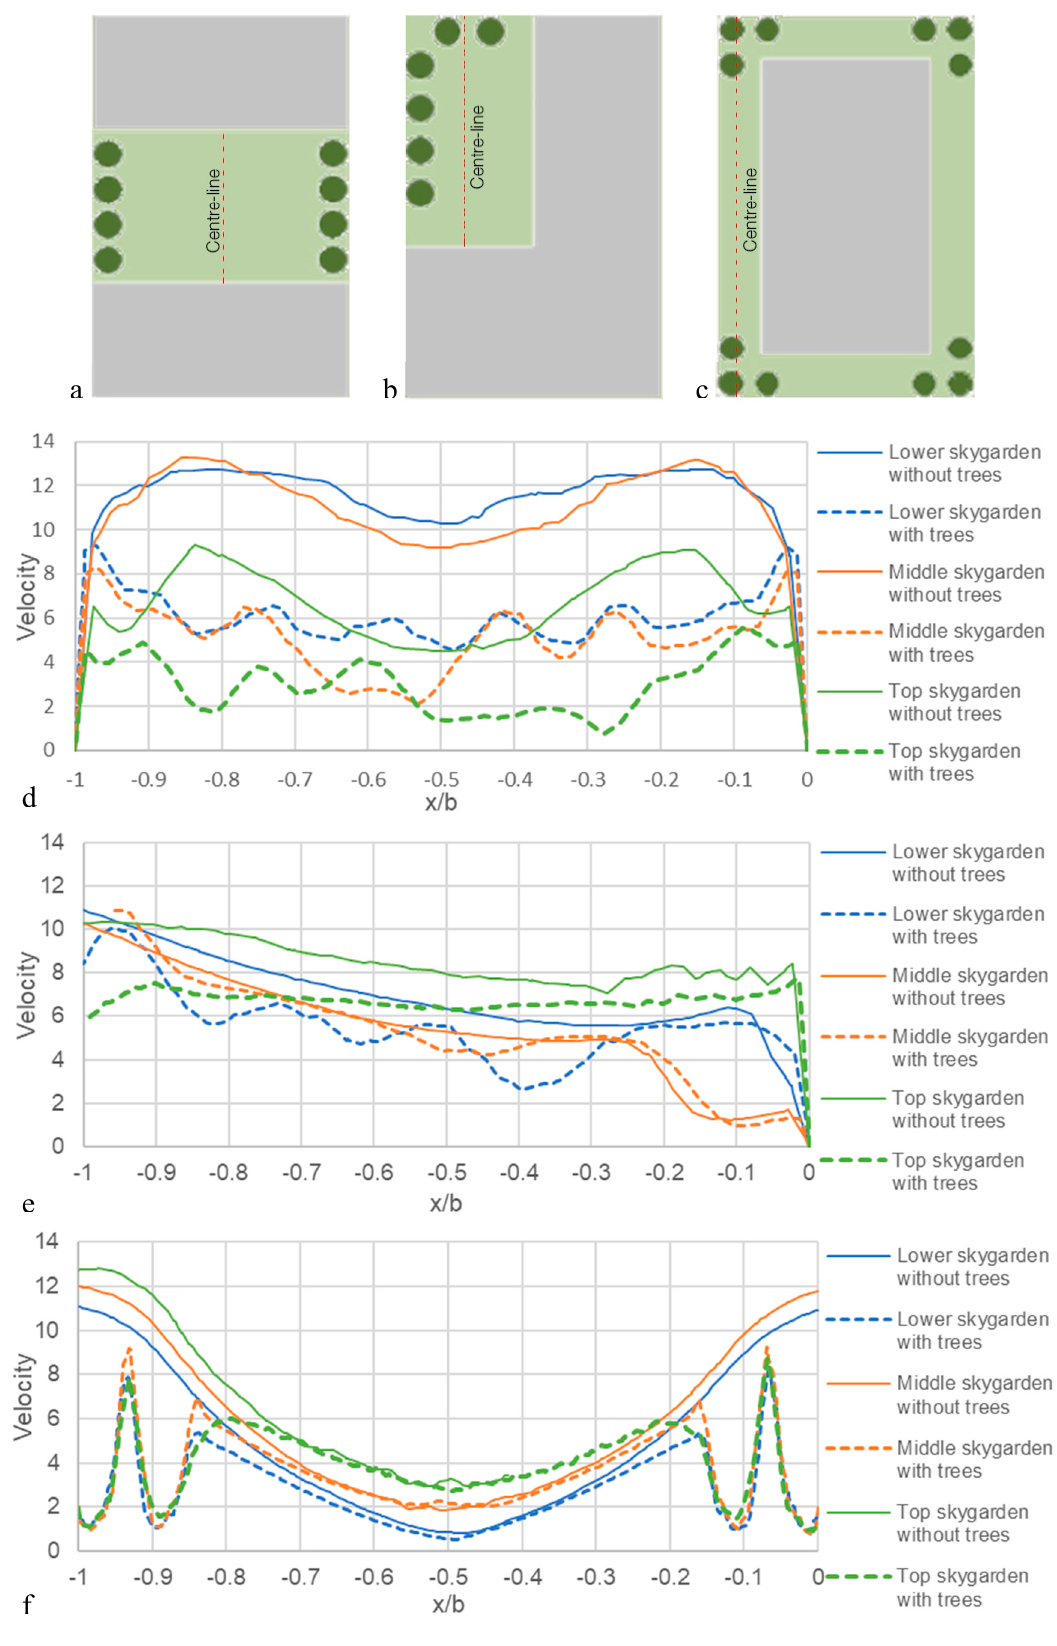
Figure 17. Location of centreline for analysis at: ( a ) Central sky garden; ( b ) corner sky garden, and ( c ) periphery sky garden; velocity profile along the centreline of ( d ) central sky garden; ( e ) corner sky garden; and ( f ) periphery sky garden.